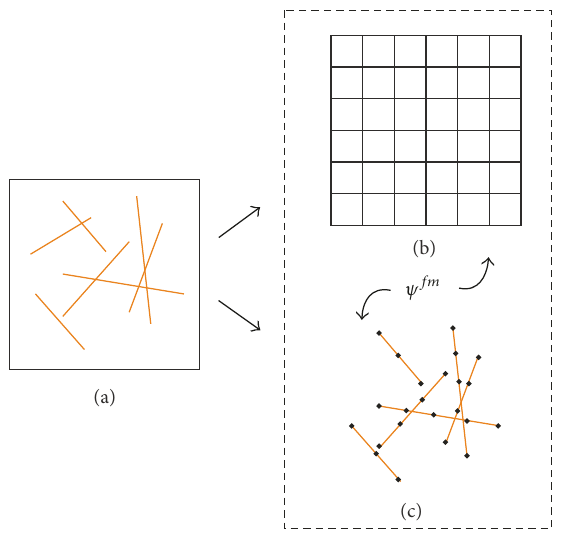
Figure 2: A fractured domain (a) is separated in a uniform grid (b) and a fracture grid (c). The two resulting domains are coupled using the transfer function Ψ 𝑓𝑚